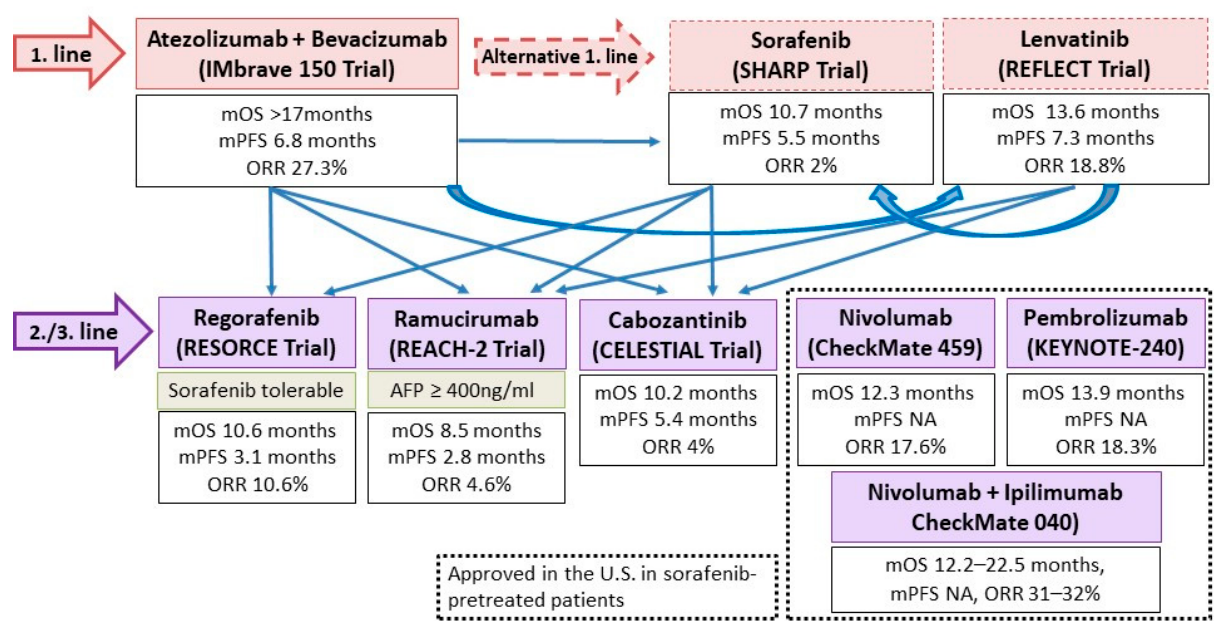
Figure 4. The current proposed clinical practice algorithm in terms of systemic therapies and sequencing options in advanced HCC. Adapted from [44]. NA, not available; mOS, median overall survival; mPFS, median progression free survival; ORR, overall response rate.